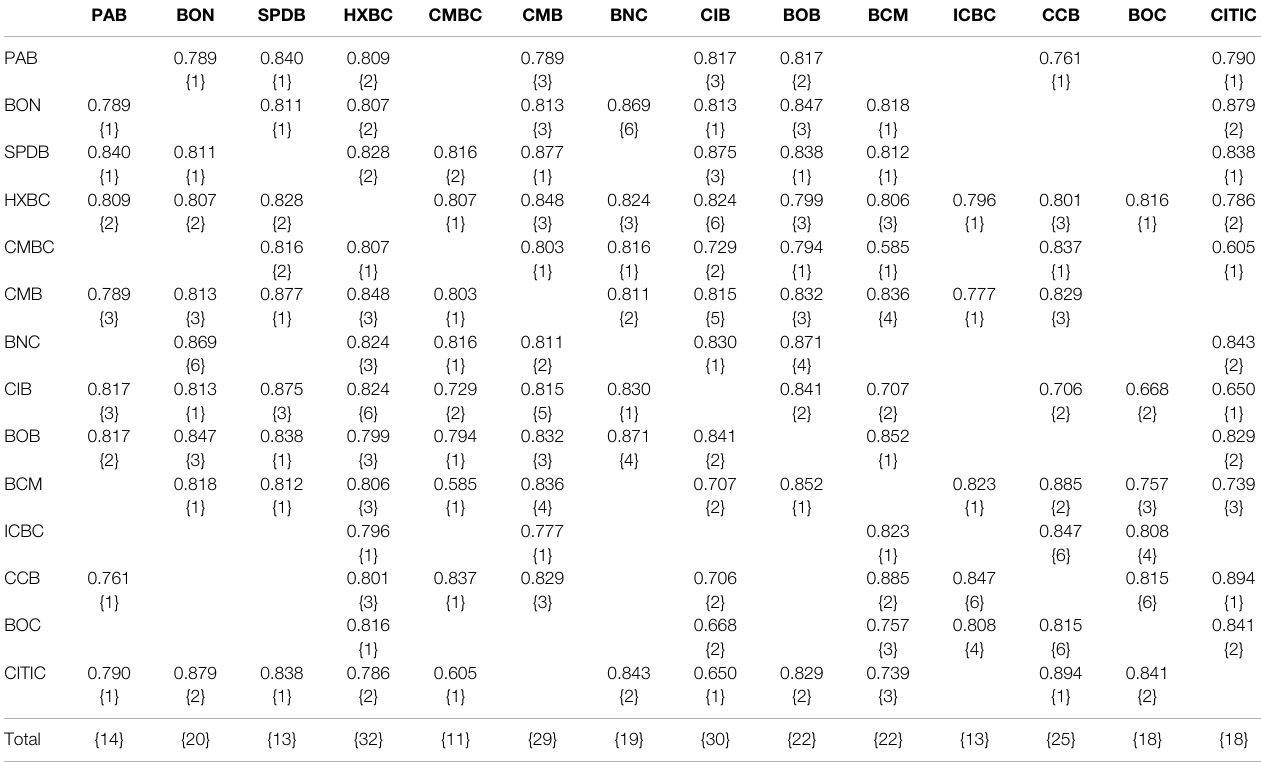
TABLE 4 | Statistics of stock price-related networks of banks from 2008 to 2018. PAB